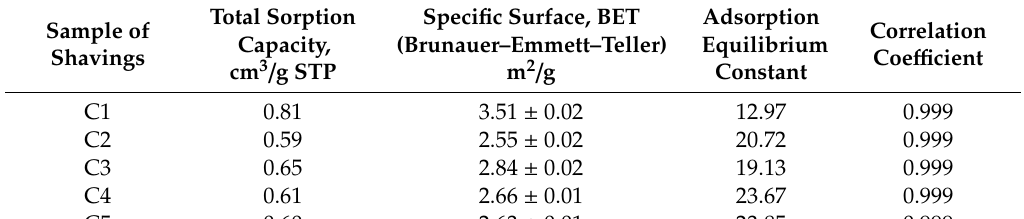
Table 2. Grain-size composition of shavings.